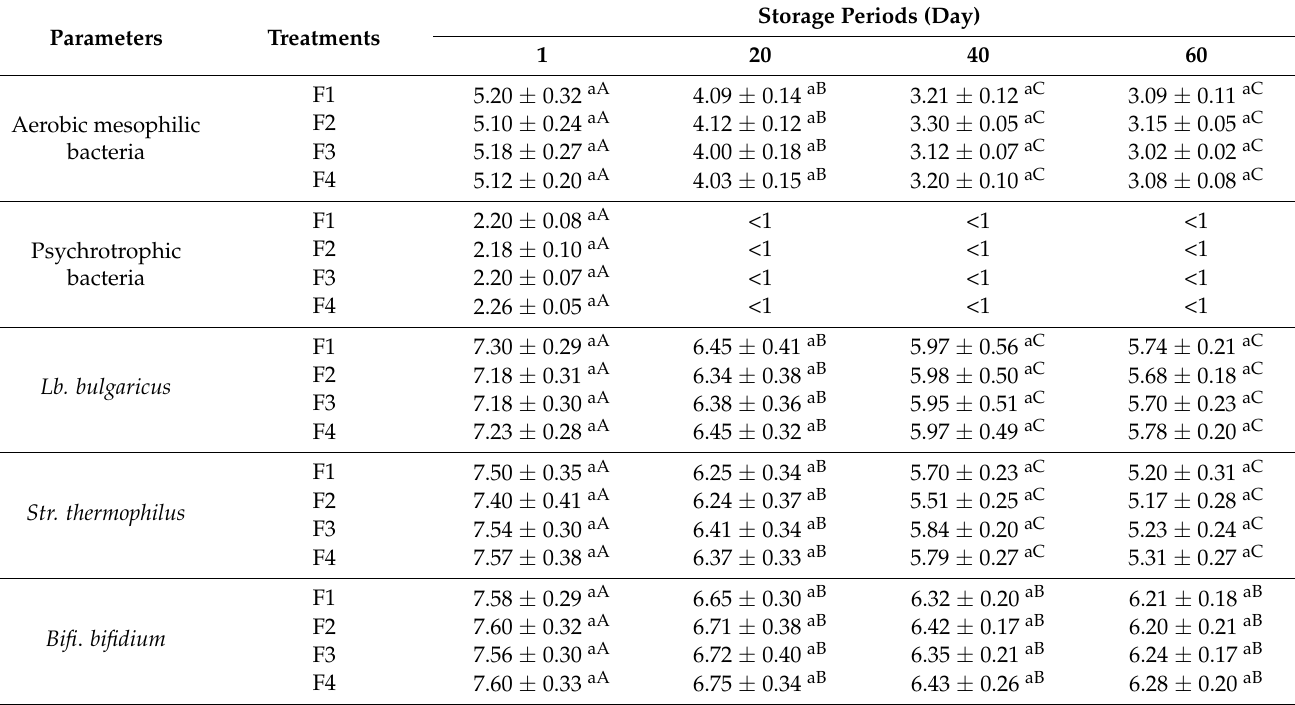
Table 5. Microbiological properties (log 10 CFU g − 1 ) of probiotic-frozen yogurts during storage